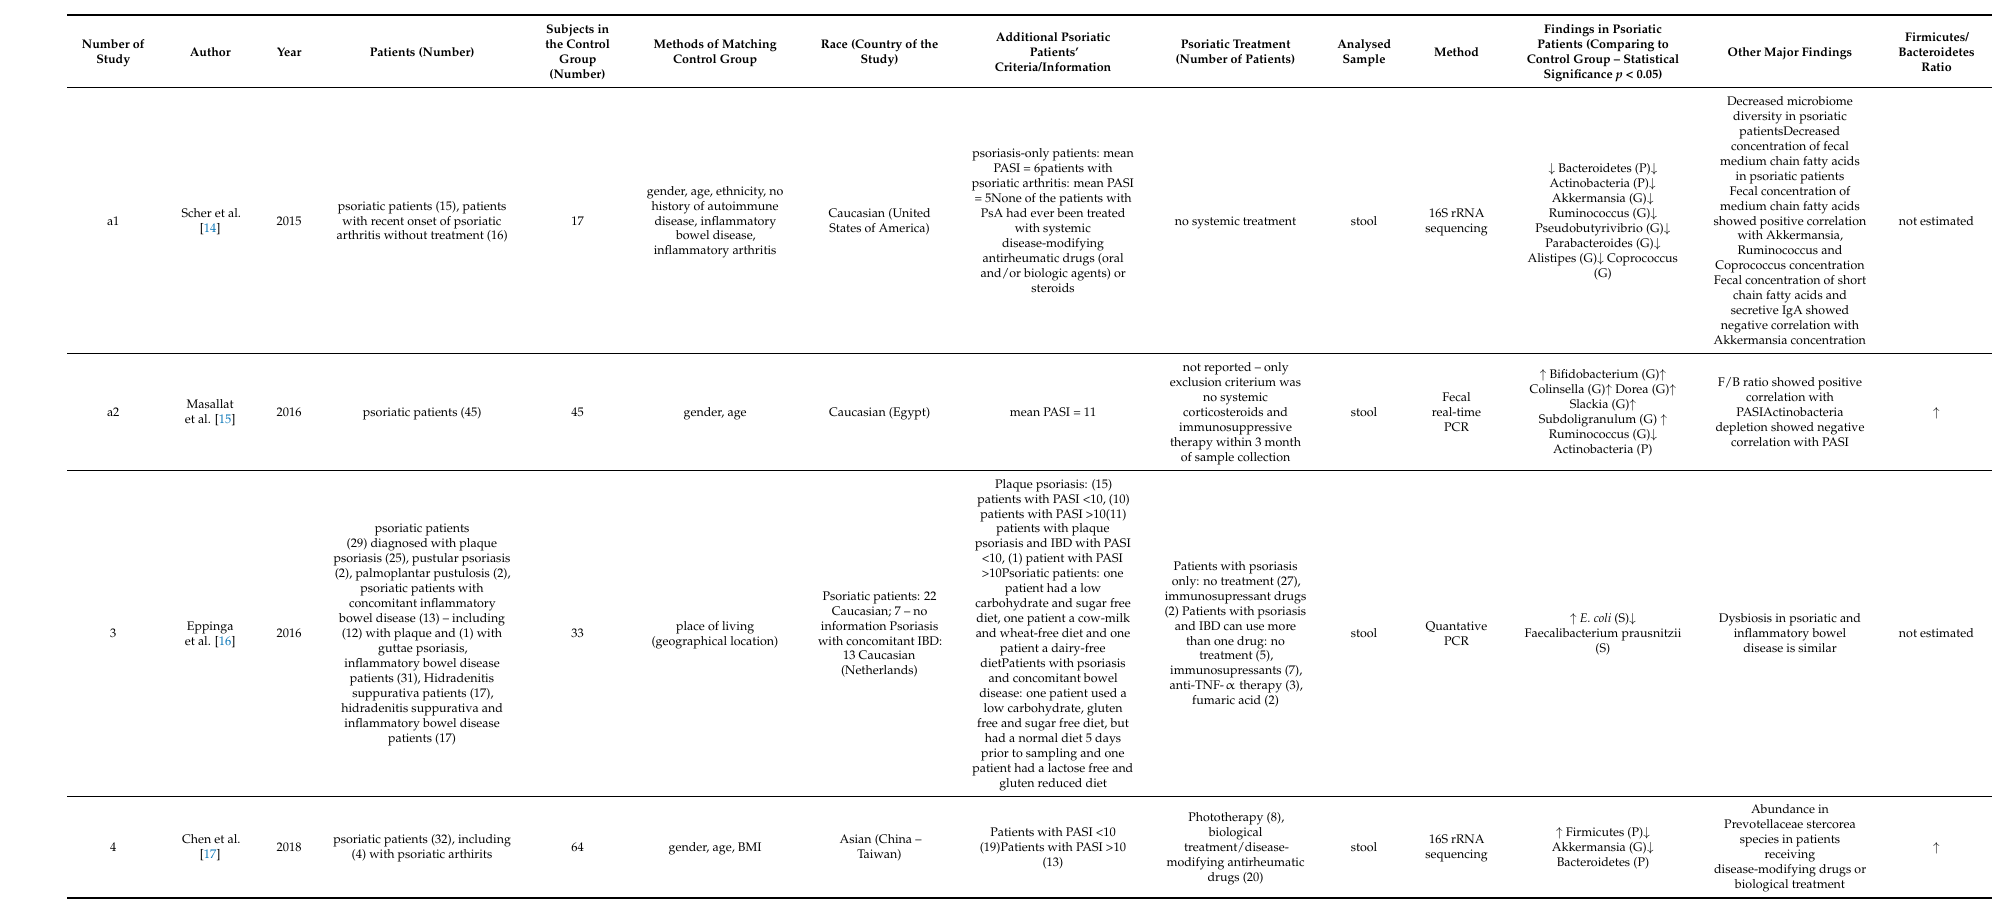
Table 1. Research on gut microbiota in